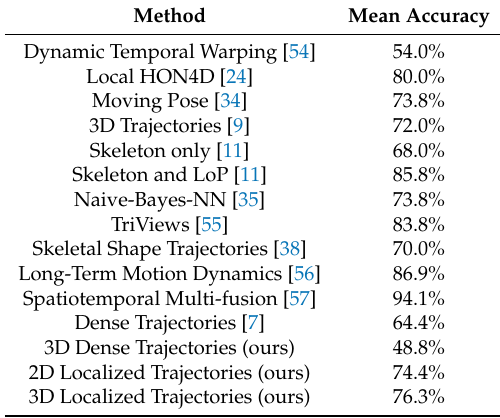
Table 1. Mean accuracy of recognition (%) on MSR DailyActivity 3D dataset for Dense Trajectories and 2D Localized Trajectories approaches against